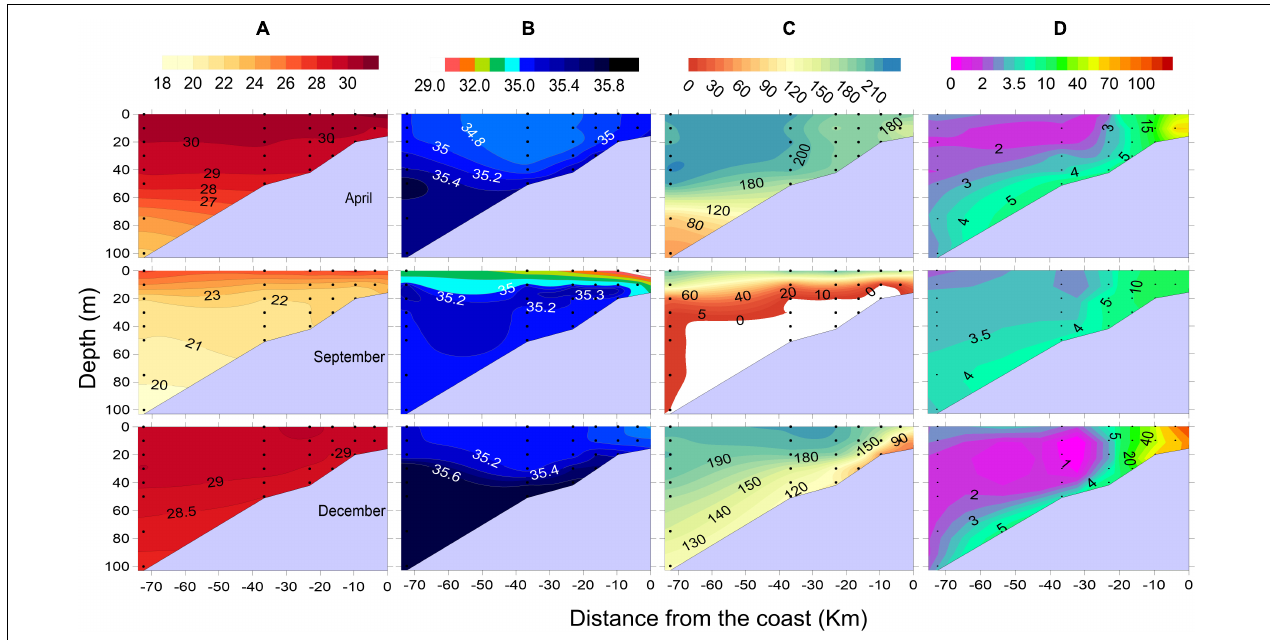
Frontiers in Marine Science |